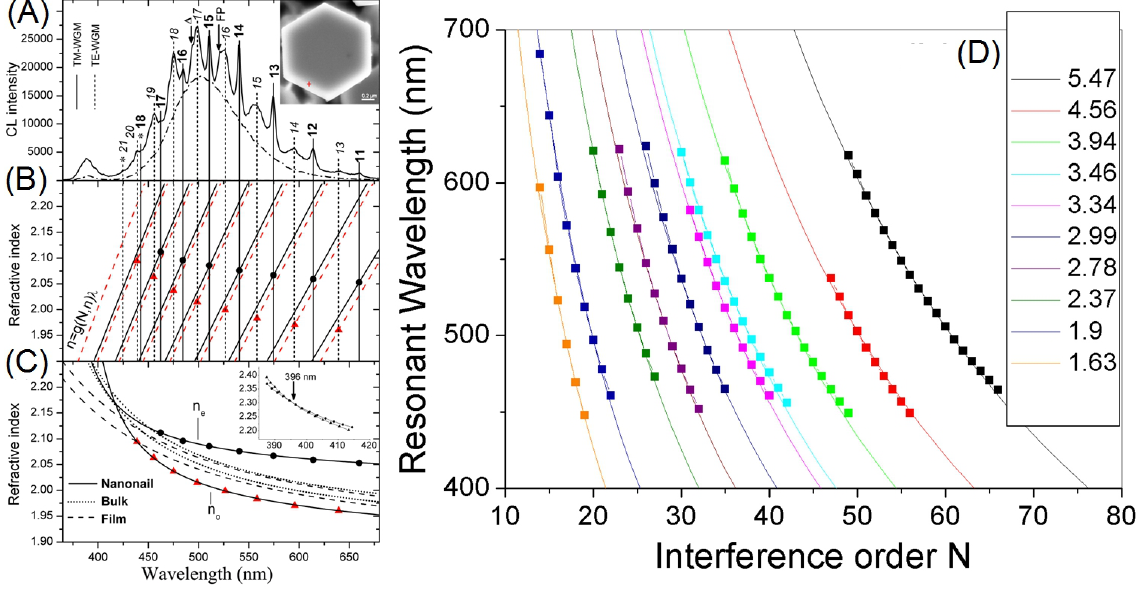
Figure 6: (A) A CL spectrum from an individual ZnO nanonail with a series of peaks corresponding to dielectric-cavity resonance modes con- voluted. The integers are the mode numbers for respective resonant mode peaks. The inset is a top-view SEM image of a ZnO nanonail with a side length of 794 nm, and the electron beam position is marked with a cross. (B) The series of scanted solid and dash lines are, respec- tively, the inverse functions of TM-WGMs and TE-WGMs equations with the corresponding mode numbers in (A). (C) The dispersion curves for TE (n o ) and TM (n e ) were deduced by fitting the peak-position refractive indices to Sellmeier’s equations. The inset shows the inversion point of bulk crystals. (D) The dependences of the resonant wavelength of TM polarization on the interference order N for different wire di- ameters. Reproduced with permission from Ref. [78] (A–C) and [80] (D). CL: cathodoluminescence; SEM: secondary electron microscope; TM-WGMs: transverse magnetic-whispering-gallery modes; TE-WGMs: transverse electric-whispering-gallery modes; TE: transverse electric; TM: transverse